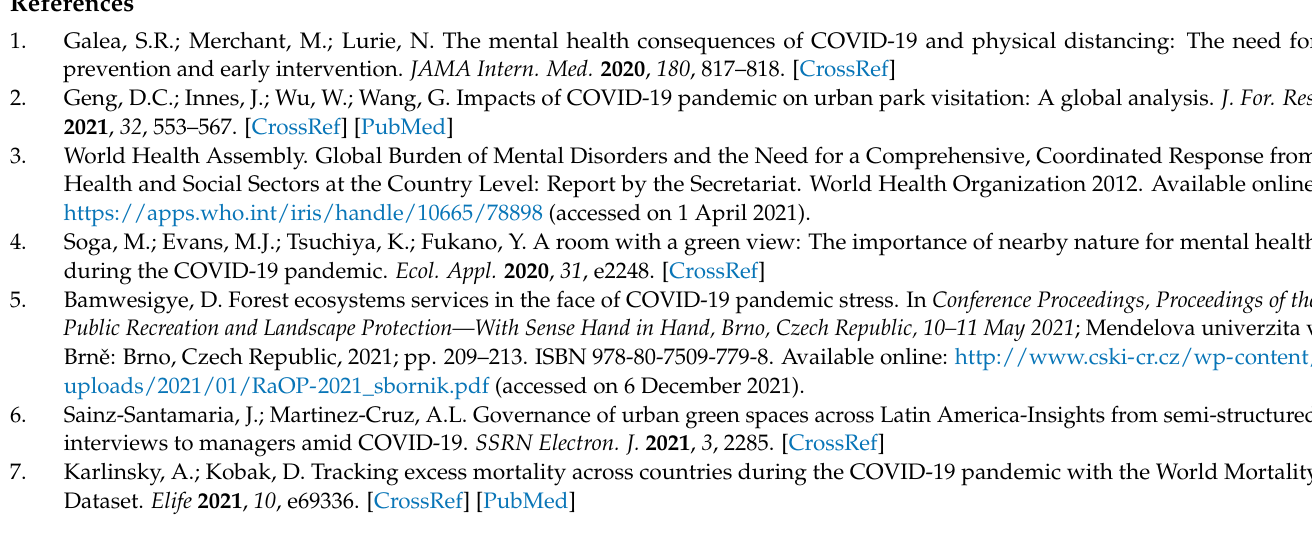
Figure A5. Recorded number of visitors per day in three months in 2021.